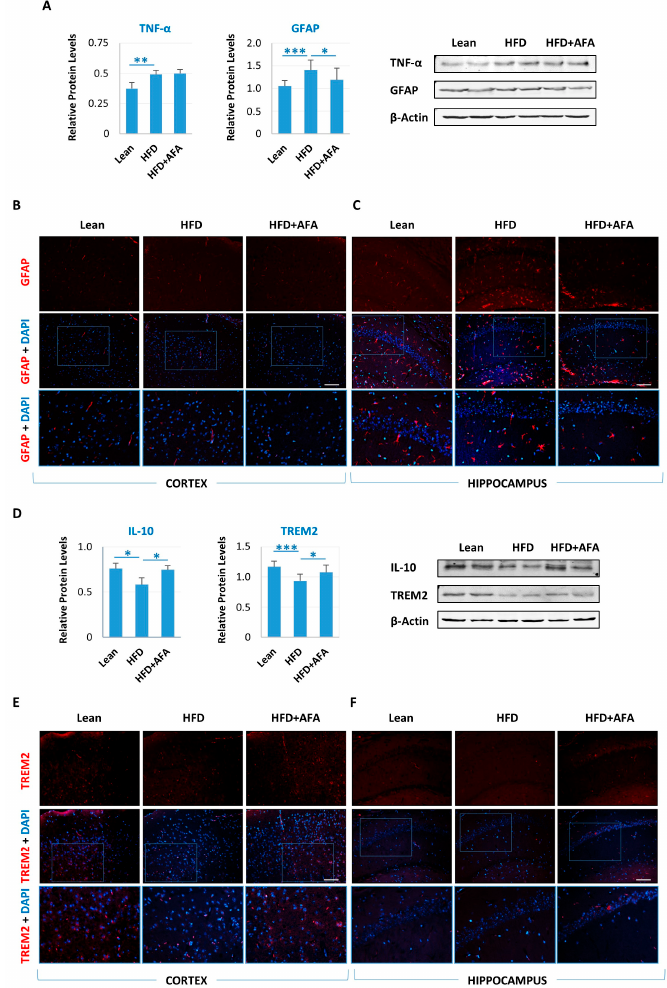
Figure 6. AFA improves inflammation induced by HFD in mouse brains. ( A ) Immunoblot of total lysate of Lean, HFD, and HFD + AFA cortex incubated with anti-TNF α , anti-GFAP, and anti- β -actin. Quantification of immunoreactivity was performed by using densitometric analysis; uniformity of gel loading was confirmed with β -actin utilized as standard. * p < 0.05, ** p < 0.005, *** p < 0.001 HFD vs. Lean and HFD + AFA vs. HFD; Representative GFAP fluorescence images of the cortex ( B ) and hippocampus ( C ) of Lean, HFD, and HFD + AFA mice. ( D ) Immunoblot of total lysate of Lean, HFD, and HFD + AFA cortex incubated with anti-IL-10, anti-TREM2, and anti- β -actin. Quantification of immunoreactivity was performed by using densitometric analysis; uniformity of gel loading was confirmed with β -actin utilized as standard. * p < 0.05, *** p < 0.001 HFD vs. Lean and HFD + AFA vs. HFD; Representative TREM2 fluorescence images of the cortex ( E ) and hippocampus ( F ) of Lean, HFD, and HFD + AFA mice. Nuclei were stained with DAPI. Scale bars, 50 µ m. The outlined areas in ( B , C , E , F ) are enlarged to show astrocytes and